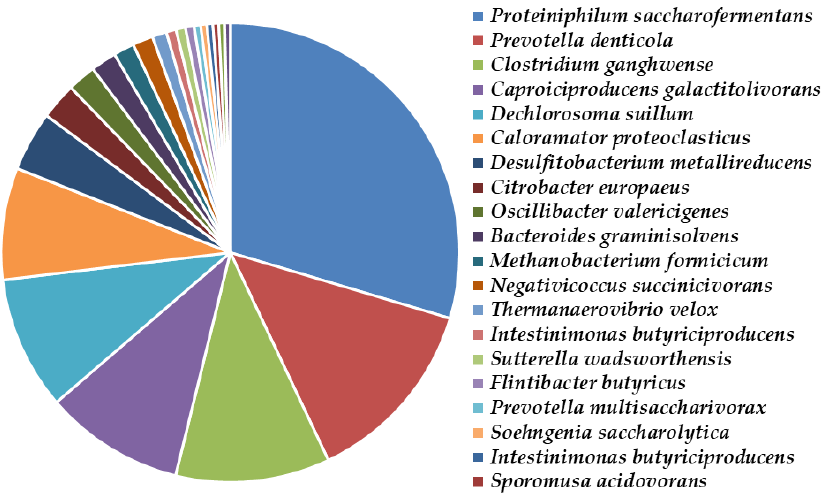
Figure 10. Species diversity in the hydrogen-producing microbial consortium inhabiting the first bioreactor.